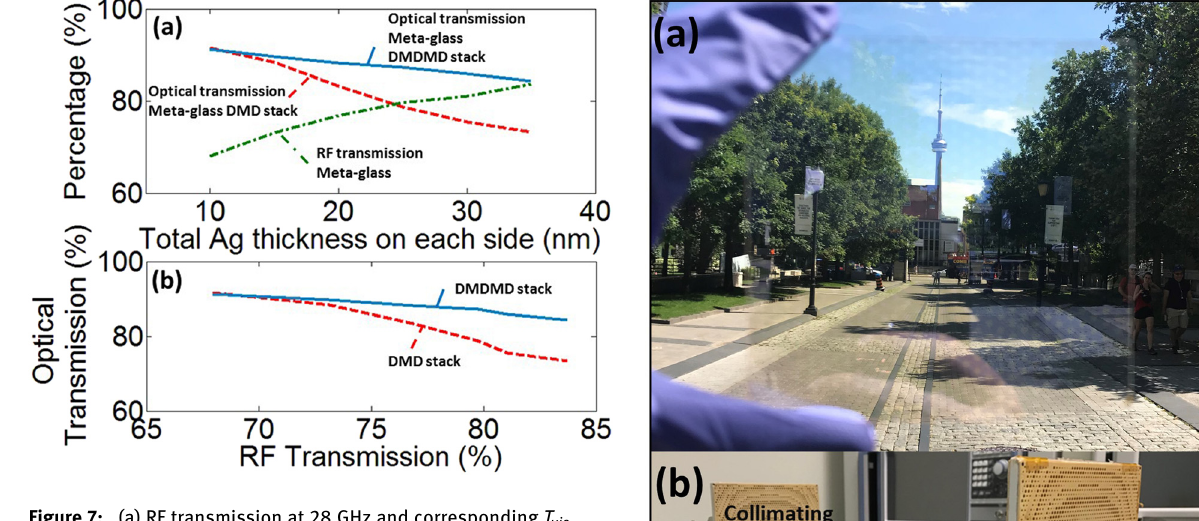
Figure 7: (a) RF transmission at 28 GHz and corresponding T vis pro fi le for the meta-glass structure composed of honeycomb meshes made of optimal spectrally selective coatings (single metal layer (DMD) and dual metal layer (DMDMD)) shown as a function of thetotalAgthicknessoneachsideoftheglasssubstrate.(b)Change in the T vis pro fi le with increasing RF transmission in meta-glass structures comprising of optimal DMD and DMDMD spectrally selective stacks.